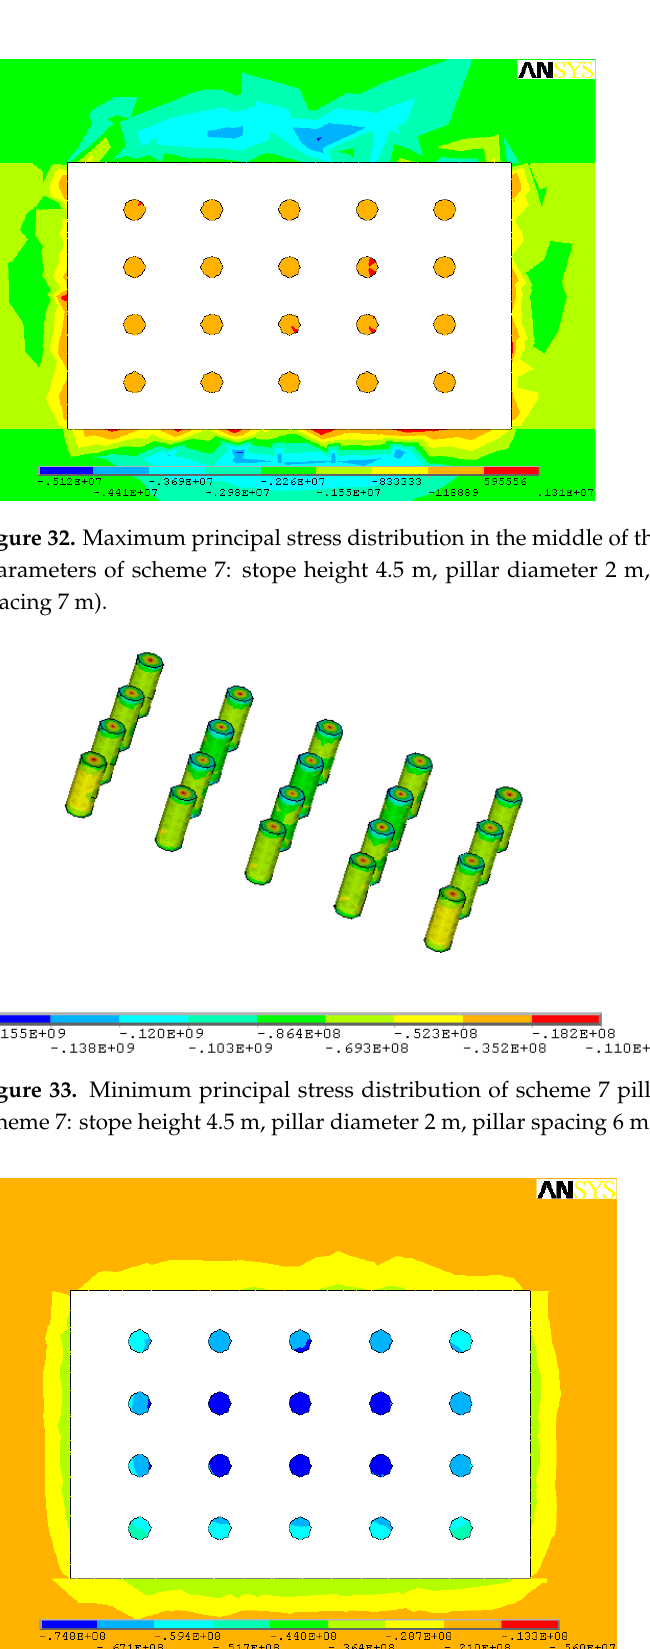
Figure 34. Minimum principal stress distribution in the middle of the pillar at 1480 mL of scheme 7 (parameters of scheme 7: stope height 4.5 m, pillar diameter 2 m, pillar spacing 6 m, pillar row spacing 7 m).